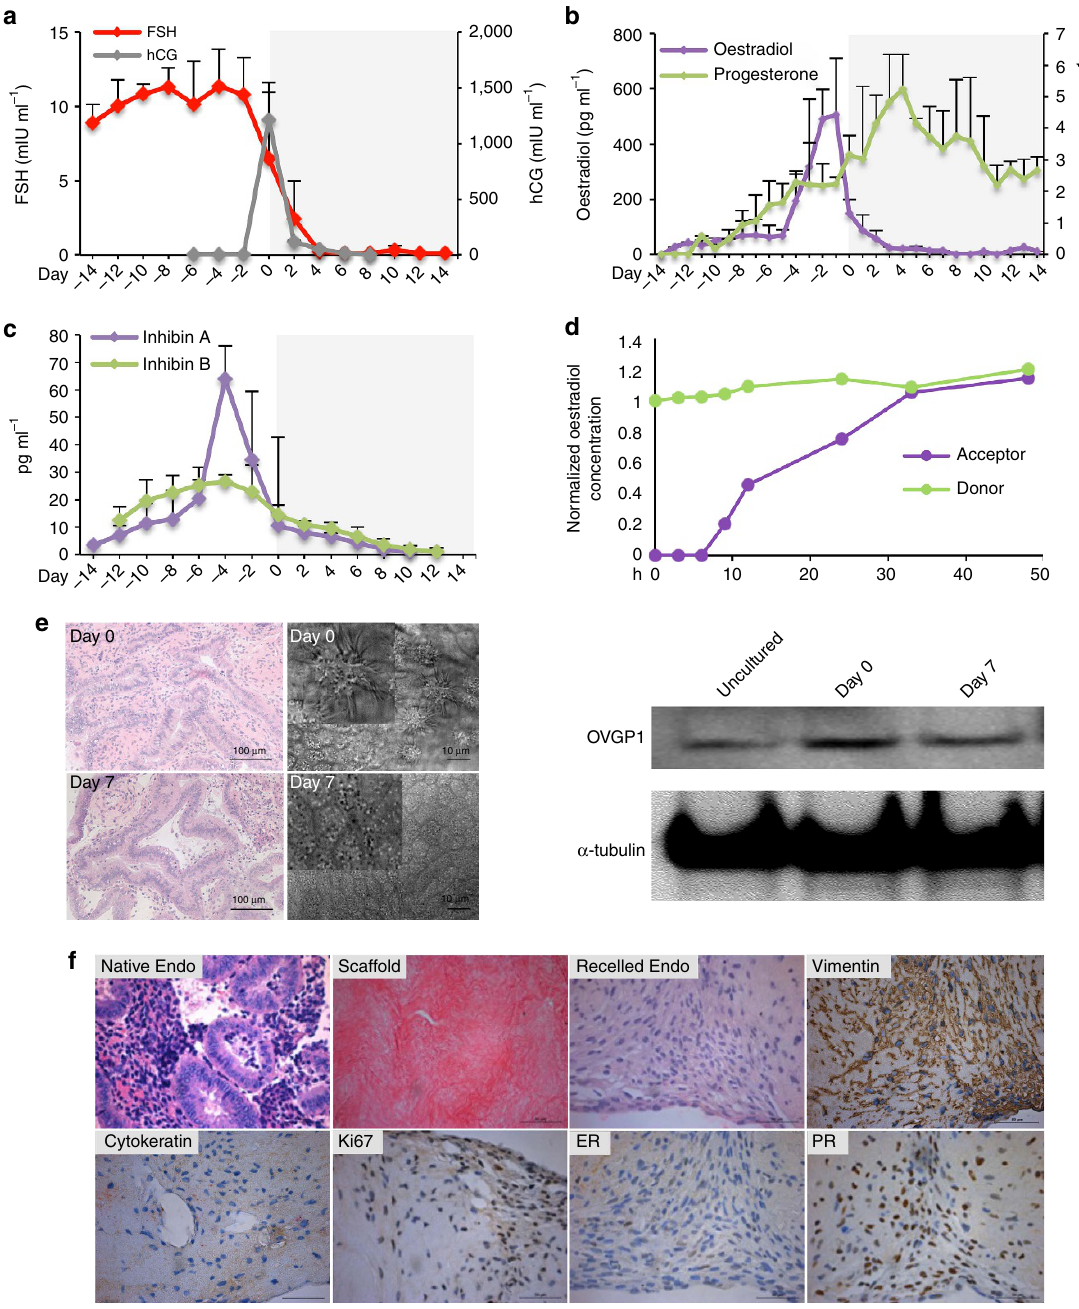
Figure 5 | The Quintet-MFP supported the integration of female reproductive tissues. ( a ) Concentrations of pituitary hormones, FSH and hCG, during 28-day culture in the Quintet-MFP. ( b , c ) Ovarian hormone secretion during 28-day microfluidic culture with oestradiol (E2) and progesterone (P4) in b and inhibin A and inhibin B in c . ( d ) Dynamic E2 concentrations in the donor and acceptor modules over 48h. ( e ) Images of fallopian epithelium histology, cilia image and OVGP1 expression on days 0 and 7 (14 and 21 days of microfluidic culture) in the Quintet-MFP. ( f ) Human endometrium tissue before and after decellularization, after recellularization, and immunohistochemistry staining of vimentin, cytokeratin, Ki67, ER and, PR on day 14 (28 days of microfluidic culture) in the Quintet-MFP. Graphs of a – d display average þ s.d. Scale bar, 100 m m for fallopian epithelium histology, 10 m m for cilia images ( e ), and 50 m m for endometrium images ( f ). OVGP1 expression: a -tubulin as internal control. n ¼ 3 replicates of the integrated tissue culture in the Quintet-MFP.